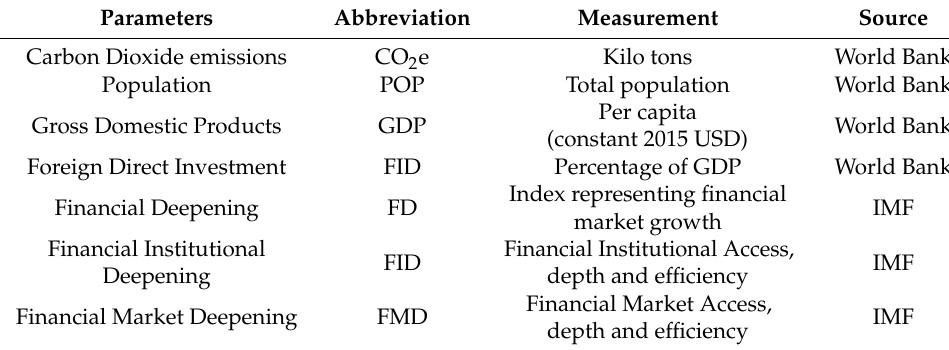
Table 1. The parameters under investigation and their